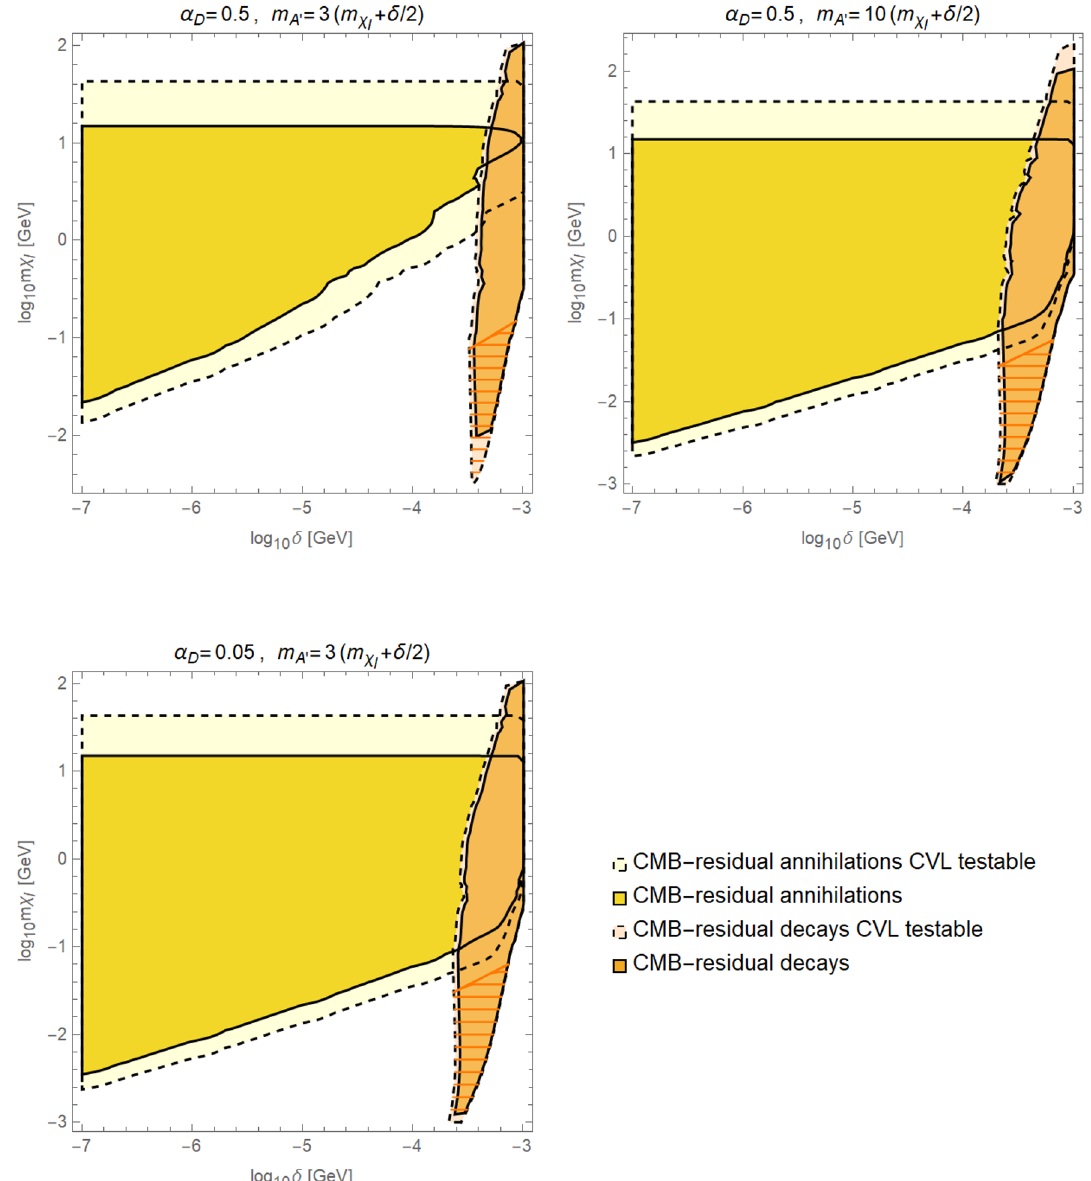
Figure 20 . Constraints arising from residual annihilations (yellow) and decays (orange) that can alter the CMB anisotropies, as in figure 5 but for different values of α contours correspond to the regions that a CVL limited experiment could probe. The striated area is the region where semi-elastic interactions may further deplete the excited state and weaken the